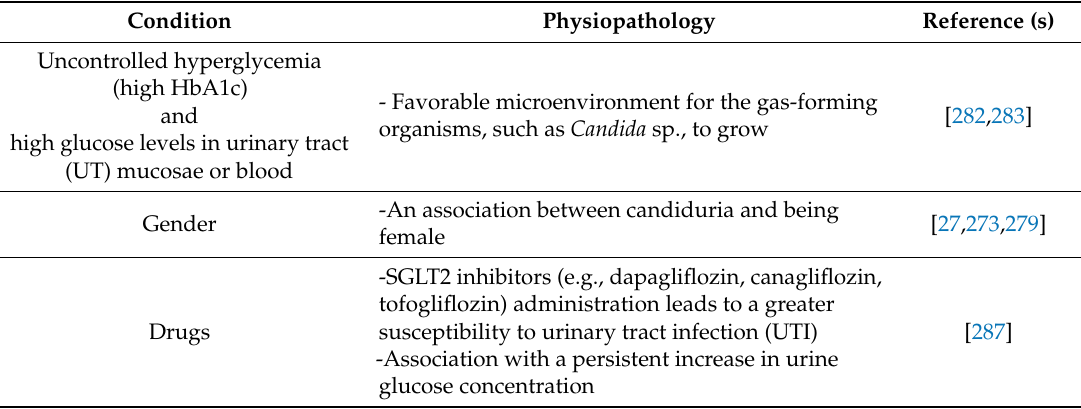
Table 3. Physiopathology and etiology related to the occurrence of urinary tract infections and systemic candidiasis in